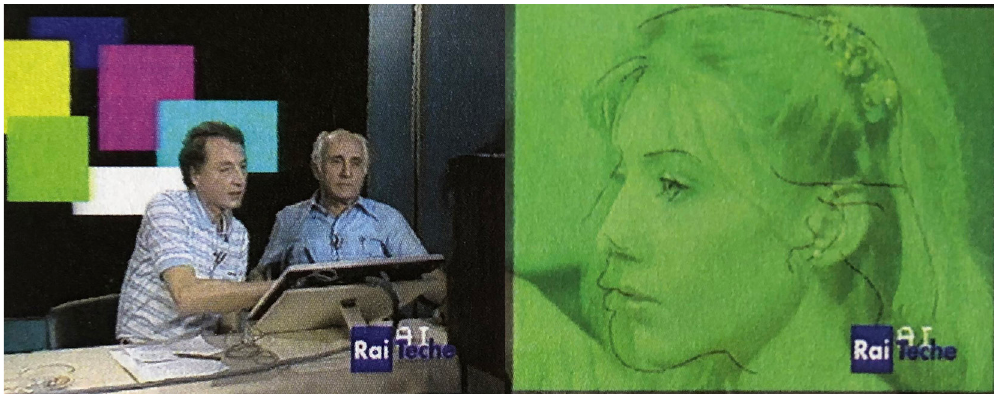
Fig. 1 Frames from the television program Pittronica (1985). On the left, Emilio Greco and Bruno Caruso at work with the Tesak workstation. On the right, the rotoscope of a woman’s